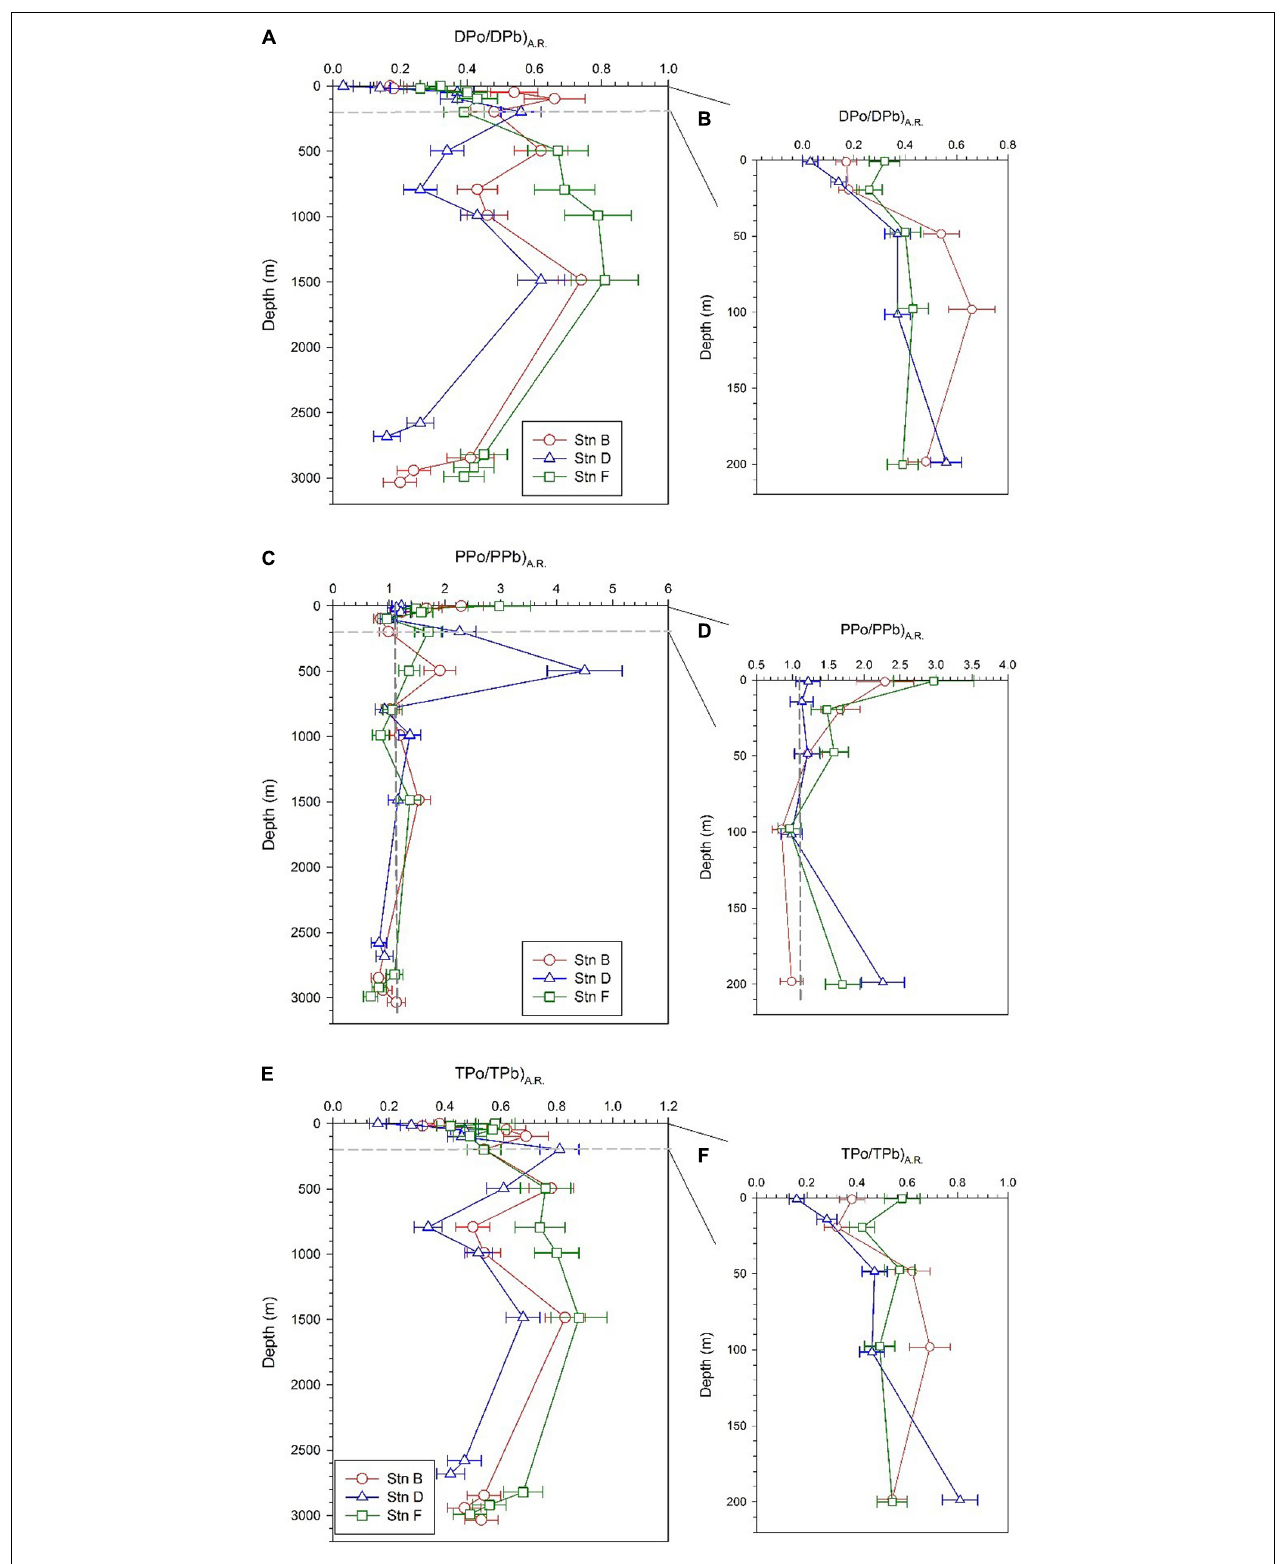
FIGURE 5 | Profiles of DPo/DPb activity ratio [(DPo/DPb) A . R . ] (PPo/PPb) A . R . and (TPo/TPb) A . R . at the three sites; panels (A,C,E) are profiles in the full water column; panels (B,D,F) are profiles in the upper 200 m.